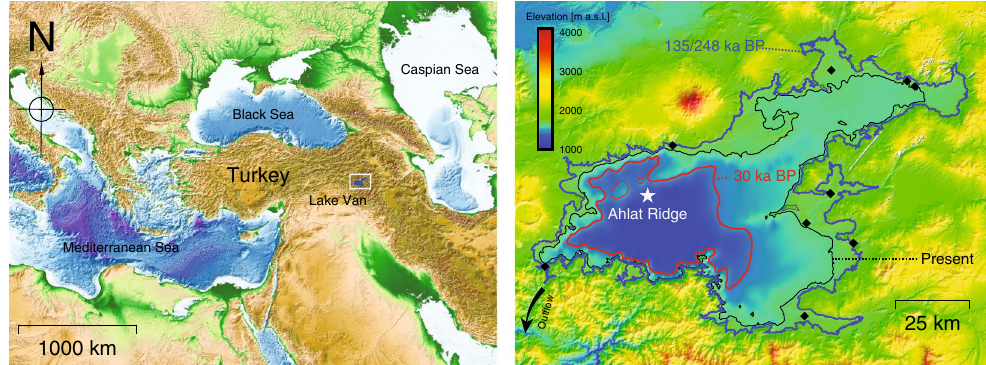
Figure 1. Left-hand panel: Overview map of eastern Europe and western Asia showing the location of Lake Van (open rectangle). The elevation data are from the Global Multi-Resolution Topography 51 . Right-hand panel: Map combining a high-resolution digital elevation model 42 and the bathymetry of Lake Van 41 used for the lake- level reconstruction in this work. The present lake level is plotted as a black contour line; past lake levels are plotted as colored contour lines (red: 30 ka BP; blue: 135 and 248 ka BP). The ICDP PaleoVan drill site at Ahlat Ridge is indicated by a white star. The spatial distribution of the terraces indicating past high lake levels 9–11 (black rhomboids) agrees well with the area of maximum extension of Lake Van during MIS5e and MIS7. The maps of both panels of Fig. 1 were created using Generic Mapping Tools (GMT) version 5.3.0 (http://gmt.soest. hawaii.edu) 52